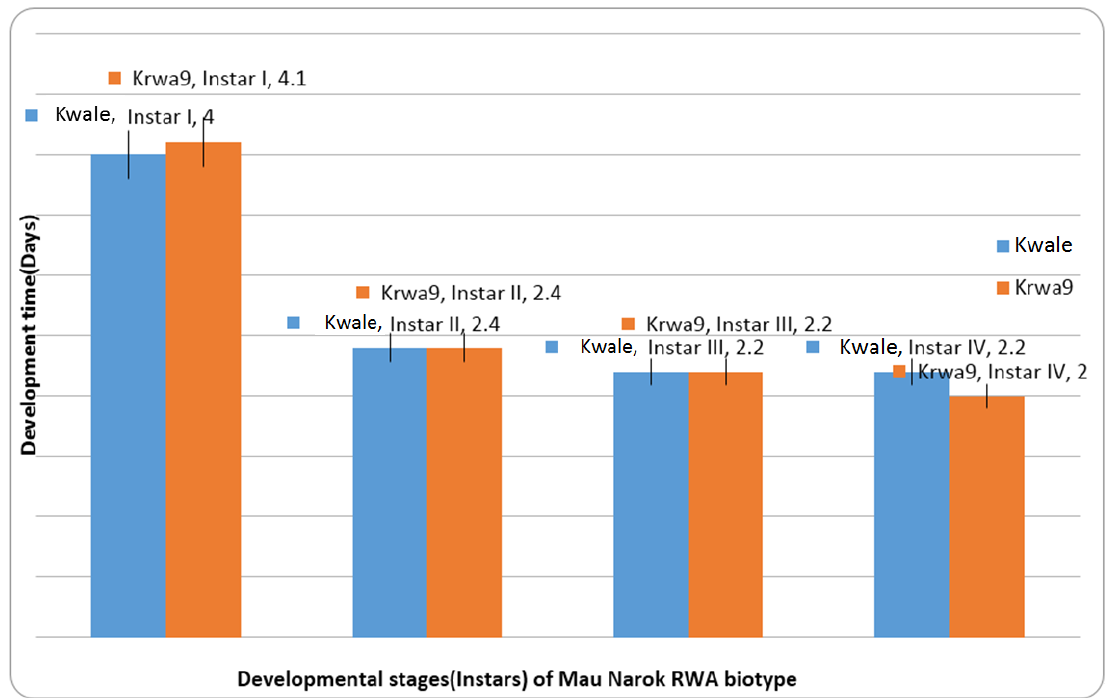
Figure 3. Development time of instars of the Mau Narok RWA population on Kwale and KRWA9. Table 4. Effect of two wheat genotypes on the development (days) of RWA populations.